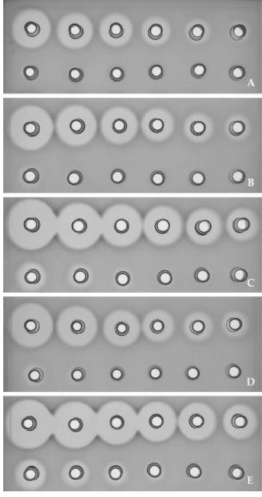
Figure 1. Antimicrobial activity of diluted supernatants of recombinant L. lactis strains as determined by an agar diffusion test (ADT) with L. garvieae CF00021 as the indicator microorganism. Supernatants from: L. lactis subsp. cremoris WA2-67 (pMG36c) ( A ), L. lactis subsp. cremoris WA2-67 (pJFAI) ( B ), L. lactis subsp. cremoris WA2-67 (pJFQI) ( C ), L. lactis subsp. cremoris WA2-67 (pJFAIQI) ( D ) and L. lactis subsp. cremoris WA2-67 (pJFQIAI) ( E ). Supernatants from recombinant strains in the upper lines were diluted 1, 2, 4, 8, 16 and 32 times, and in the bottom lines were diluted 64, 128, 256, 512, 1024 and 2048